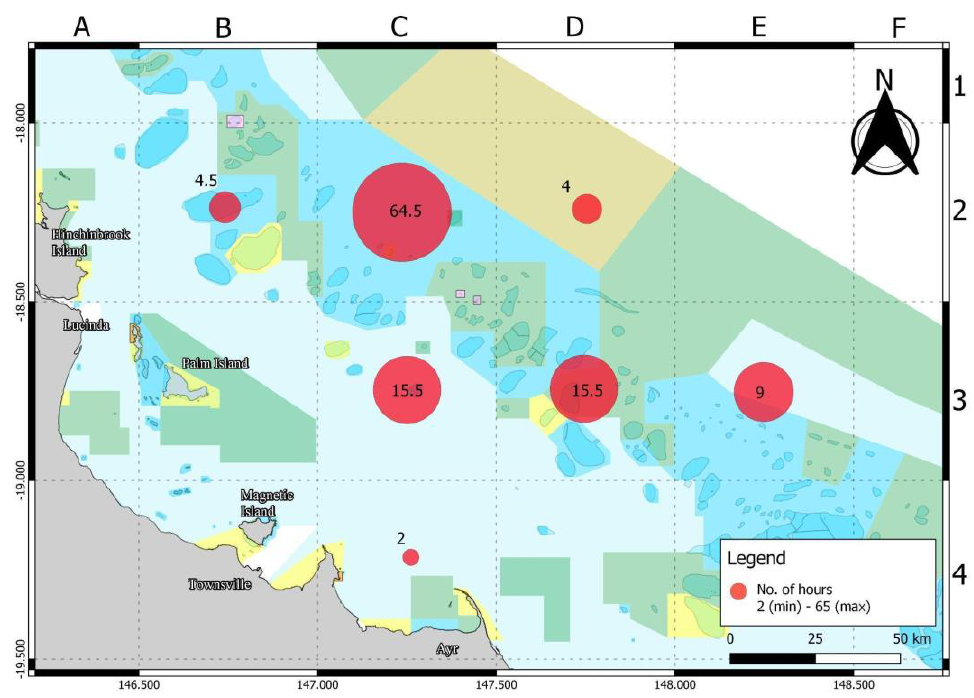
Figure 2. Total effort (hours) of spearfishers between 27–28 November 2021. Grid letters A–F and numbers 1-4 are used to label locations of NQBI competition.